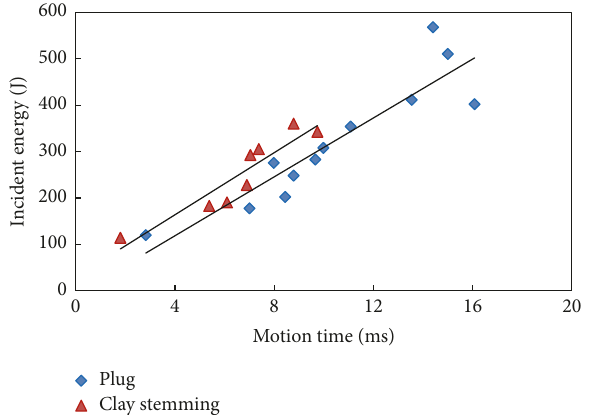
Figure 6: Relationship between the impact incident energy and motion time.